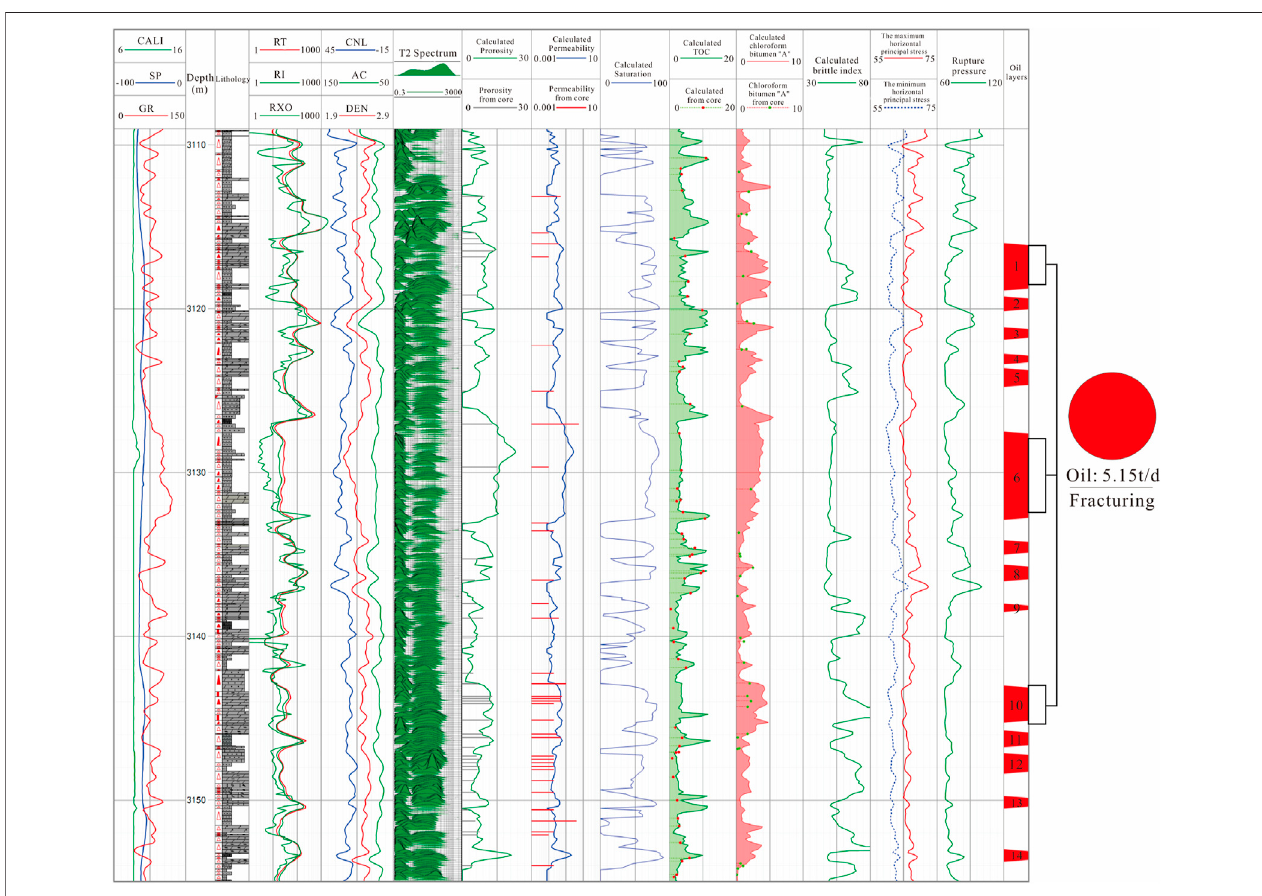
FIGURE 20 | “ Seven properties ” evaluation map of